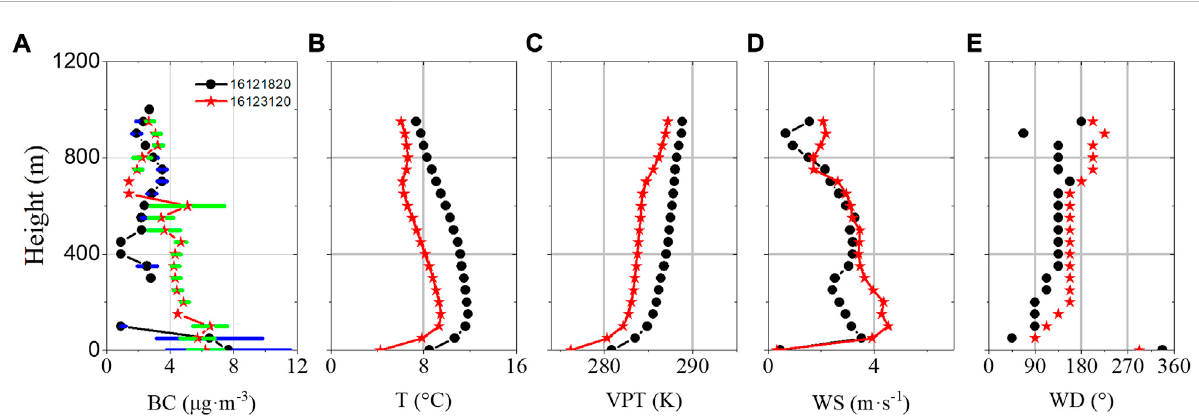
FIGURE 5 Thermally controlled transformation of unstable to stable boundary BC, T, VPT, WS and WD contours. The black line indicates the contours of eachelementat2016121820andtheredlineindicatesthecontoursofeachelementat2016123120.GreenandbluelinesareBCerrorbars. (A) black